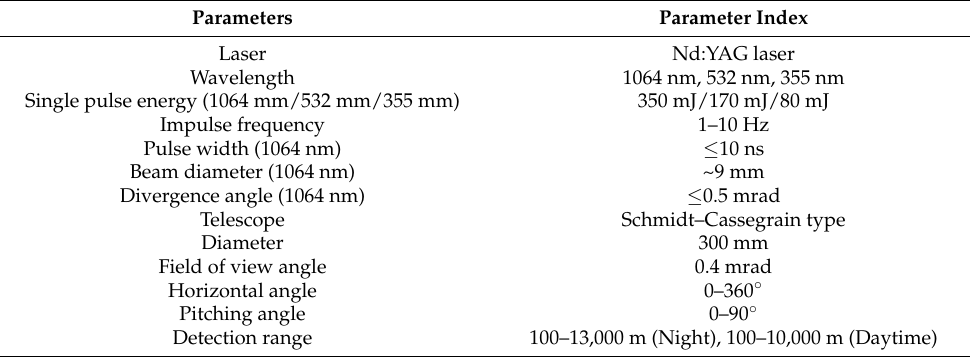
Table 2. System parameters of the Mie scattering